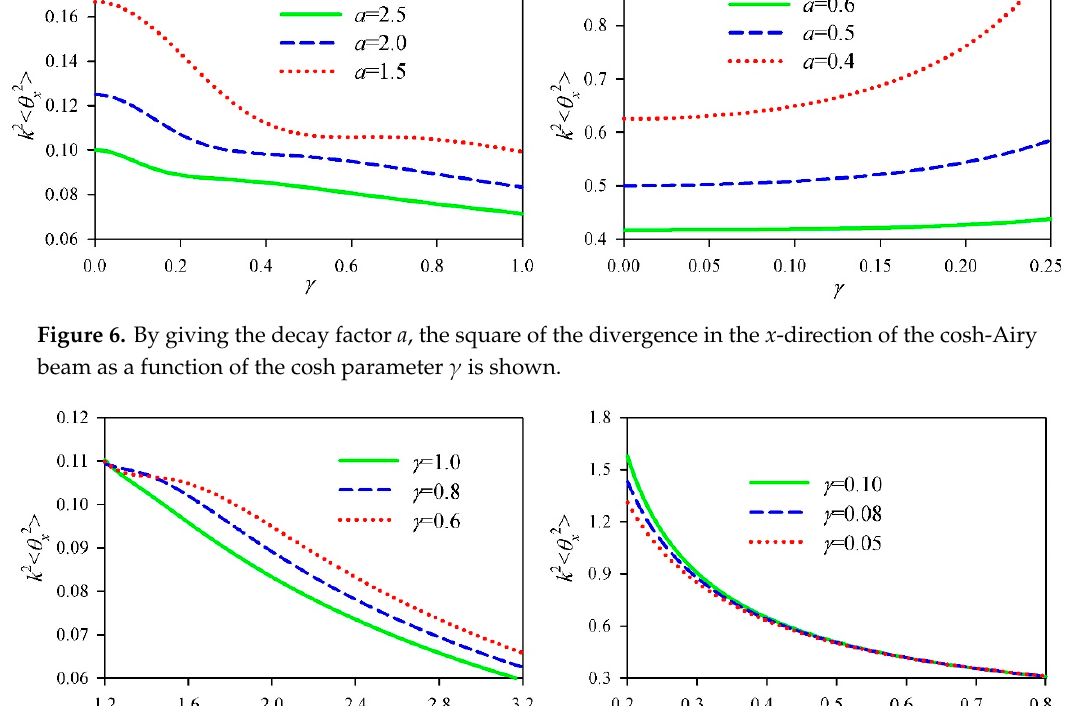
Figure 7. By giving the cosh parameter γ , the square of the divergence in the x -direction of the cosh-Airy beam as a function of the decay factor a is shown.